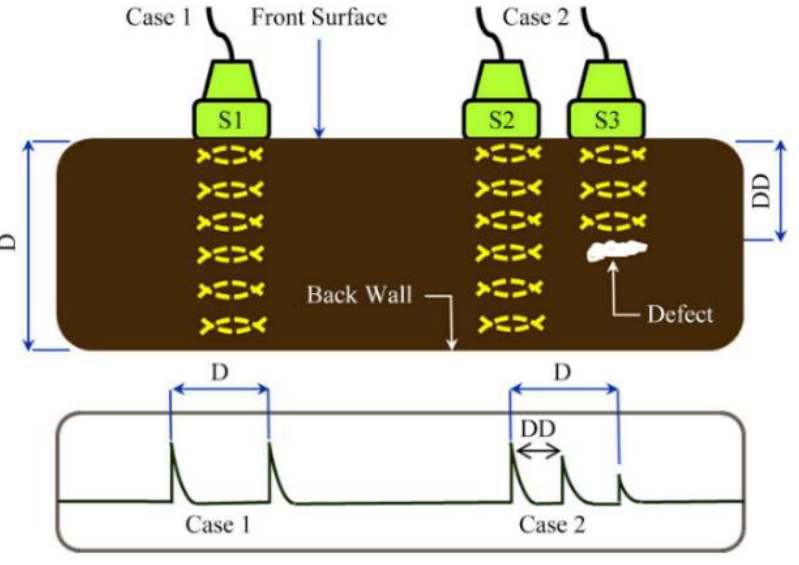
Figure 3. Ultrasonic testing principle. Reprinted from ref. [31].